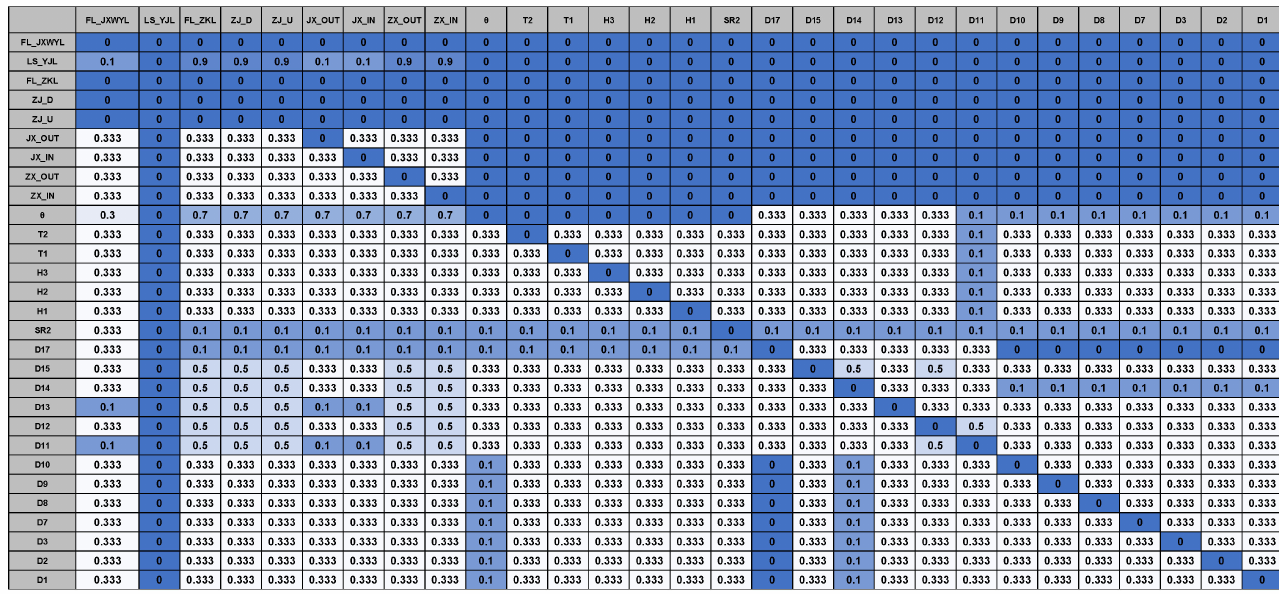
Figure 3. The fused expert knowledge matrix for RPV sealing